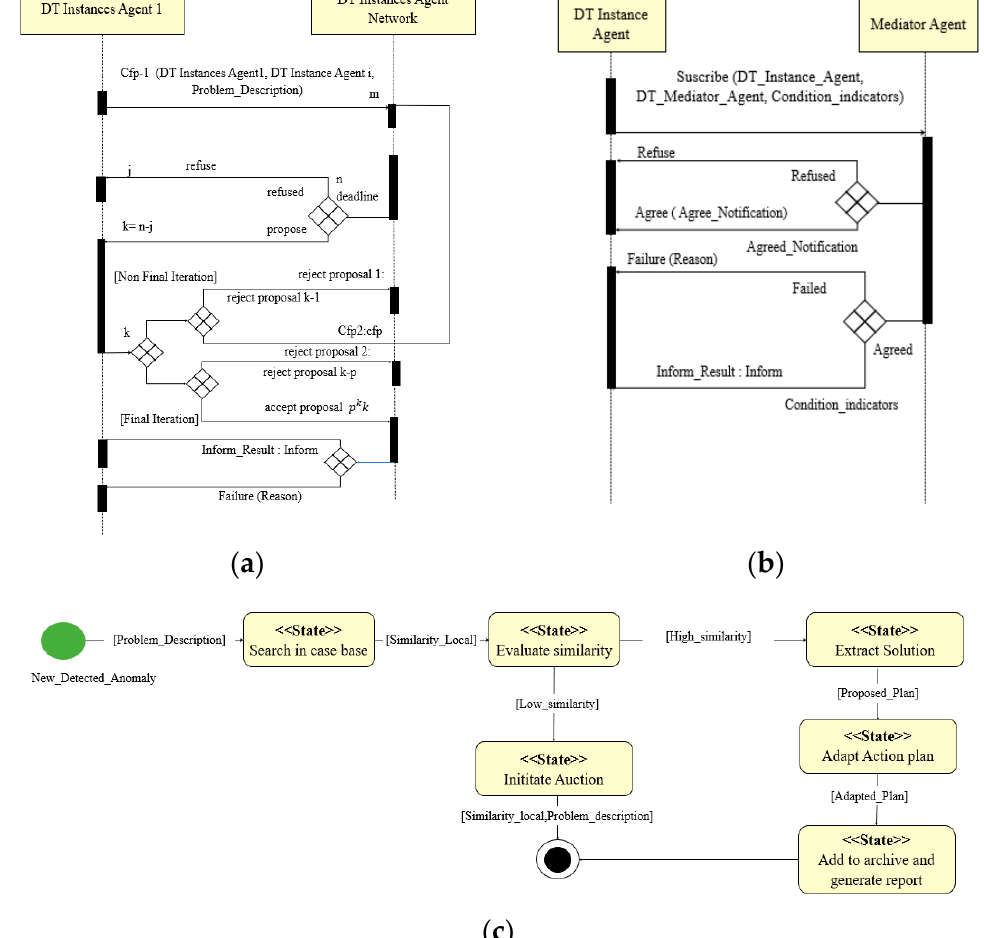
Figure 10. Protocol model for auction bidding among instances ( a ). Protocol model for instances and mediators’ communication of observations ( b ). Plan model for case-based reasoning ( c ) .